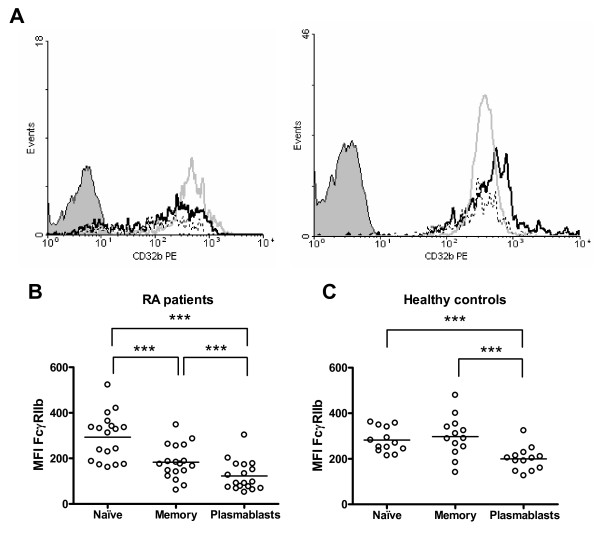
Altered regulation of FcγRIIb on B cells from rheumatoid arthritis (RA) patients. (a) Representative histograms of FcγRIIb (CD32b) expression on naïve B cells (gray line), memory B cells (black line), and plasmablasts (dotted line) from an RA patient (left) and a healthy control (right). The shaded curve represents the isotype control. Graphics show a comparison of FcγRIIb expression between naïve B cells, memory B cells, and plasmablasts from 18 RA patients (b) and 13 healthy controls (c). Expression was quantified as mean fluorescence intensity (MFI). The differences in the FcγRIIb expression levels between B-cell subpopulations were analyzed with the two-tailed paired Student t test; ***P < 0.001. Horizontal lines represent mean values. PE, phycoerythrin.